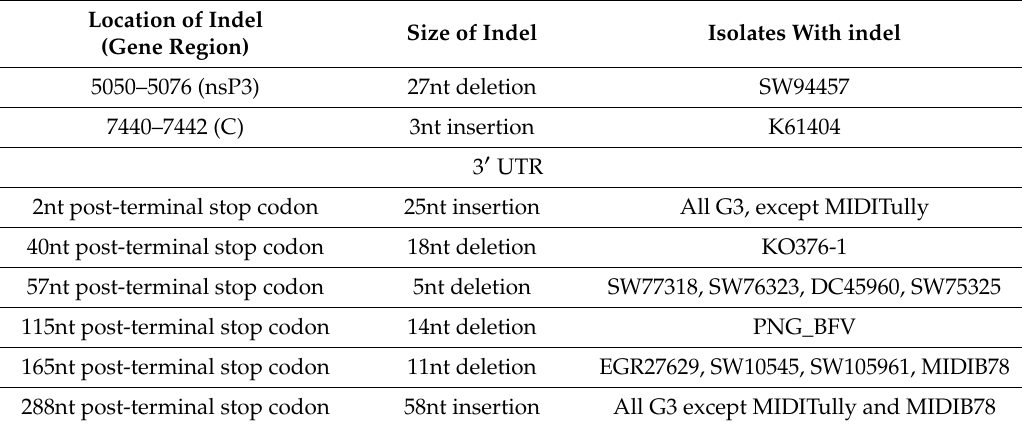
Table 3. Nucleotide insertion and deletions (indels) within the nsP3 and 3 (cid:48) UTR of the 34-taxon BFV alignment. The genomic position, indel size and isolates with the reported indel are presented. The location of 3 (cid:48) UTR indels is expressed as the number of nucleotide (nt) residues it is from the terminal stop